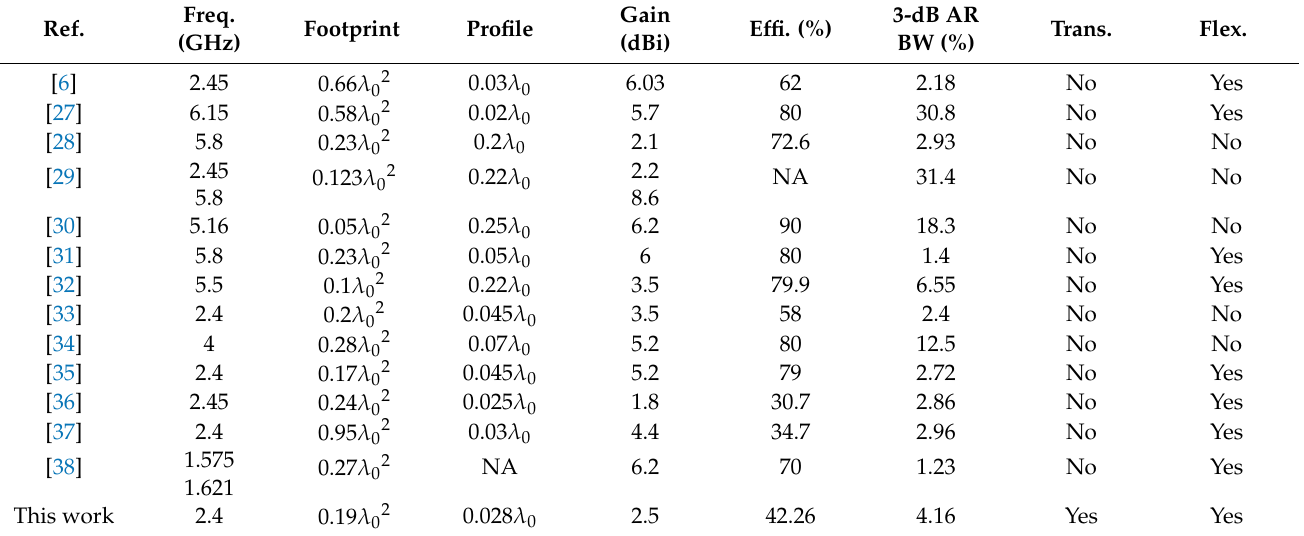
Table 4. Comparison of the proposed antenna with some state-of-the-art CP wearable antennas. Ref.